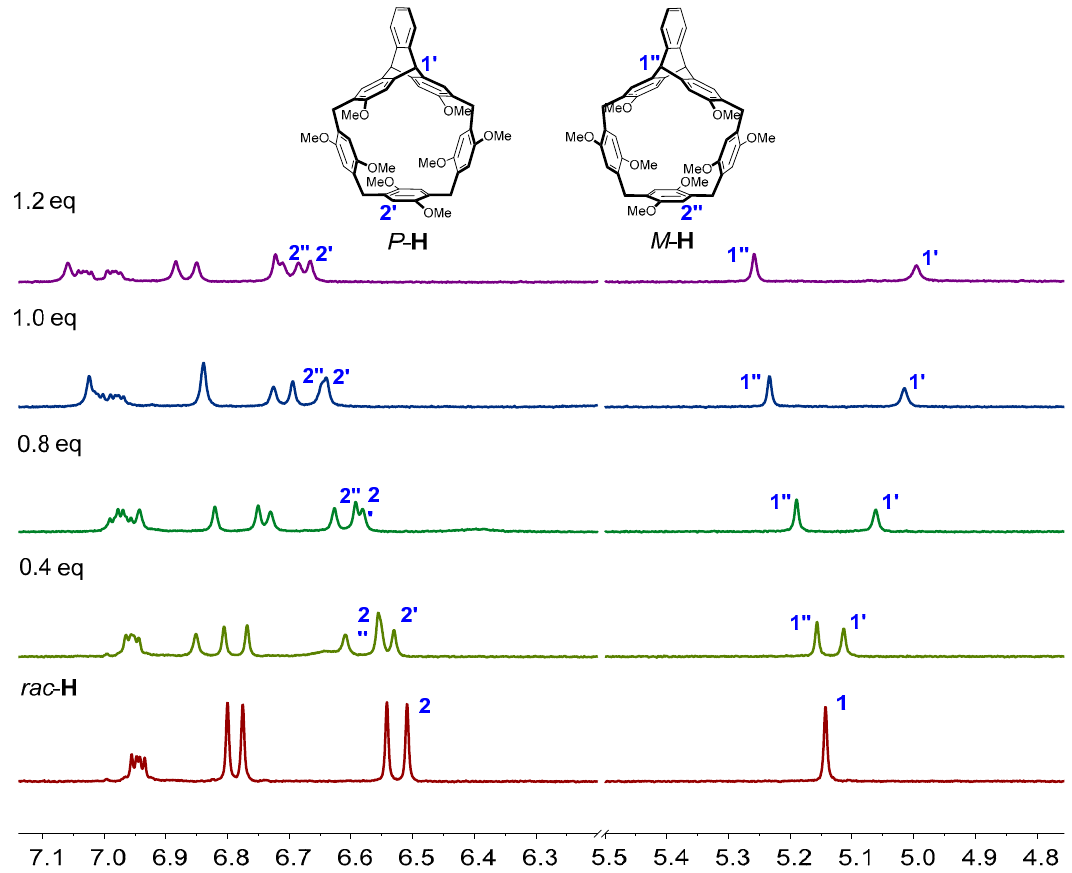
Figure 5. Partial 1 H NMR spectra (400MHz, 298 K, CDCl 3 ) of 2.0 mM rac - H with different amounts of R - G1 .